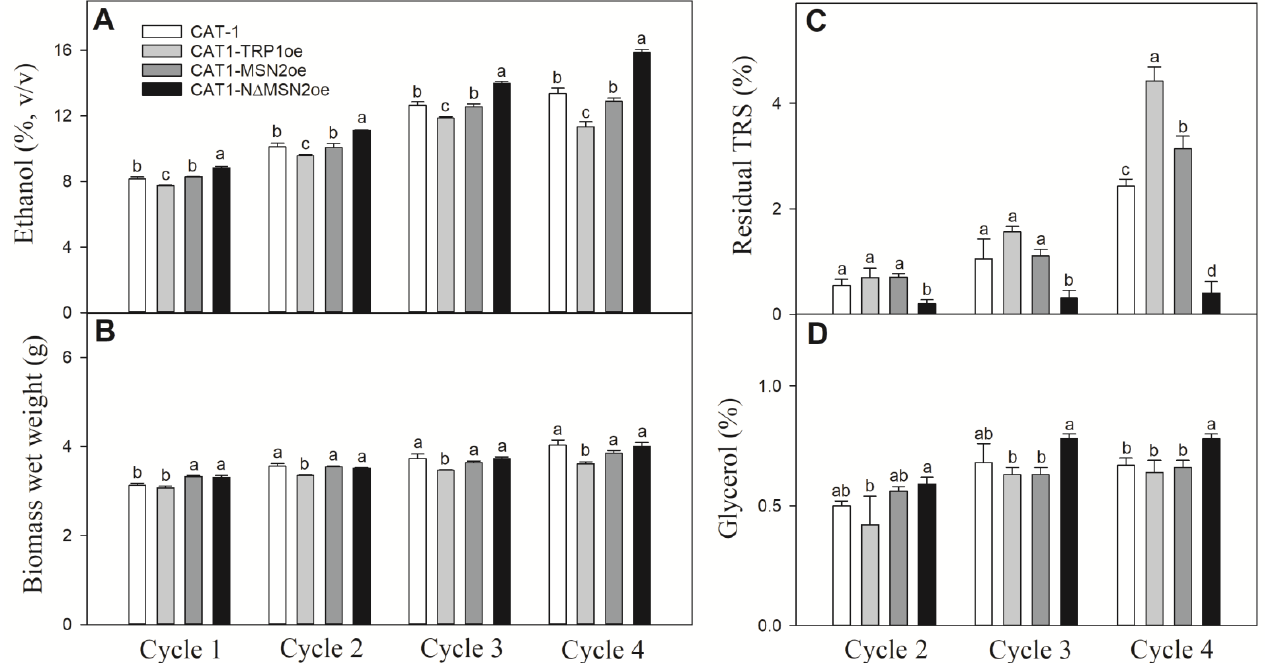
Figure 5. Fermentation performance under scaled-down and mimicked process resembling Brazilian sugarcane biorefineries by strains CAT-1 (white bars), CAT1-TRP1oe (gray bars), CAT1-MSN2oe (dark gray bars), and CAT1-N ∆ MSN2oe (black bars). ( A ) Ethanol produced during each cycle; ( B ) Wet biomass at the end of each cycle; ( C ) Residual TRS left at the three last cycles; ( D ) Glycerol produced during the three last cycles. Within each cycle, bars with different lowercase letters indicate significant differences between strains ( p < 0.05).